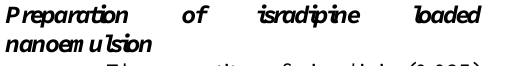
Figure 2. Pseudo ternary phase diagrams for different S mix ratio (tween 20: transcutol 1:1, 1:2, 1:3,1:4 and 2:1)